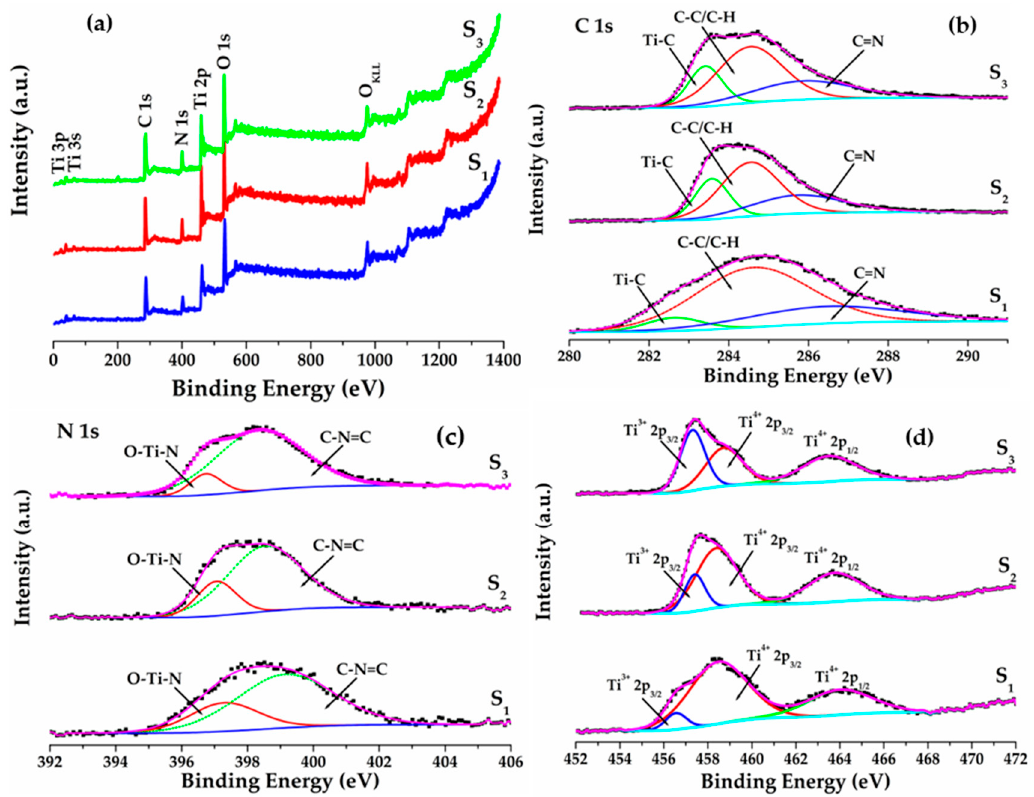
Figure 4. ( a ) The XPS survey spectra, ( b ) high-resolution C 1s, ( c ) high-resolution N 1s and ( d ) ◦ C for 105 min, 120 min and 130 high-resolution Ti 2p for C–N–TiO 2 catalysts calcined at 350 ° C for 105 min, 120 min and 130 min. ( d ) high-resolution Ti 2p for C–N–TiO 2 catalysts calcined at 350